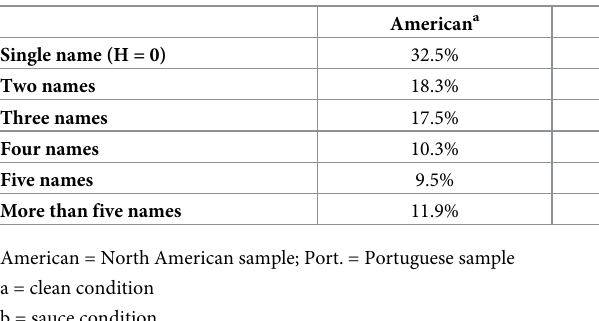
Table 3. Proportion of stimuli that yielded one, two, three, four, five, or more than five names in each sample.